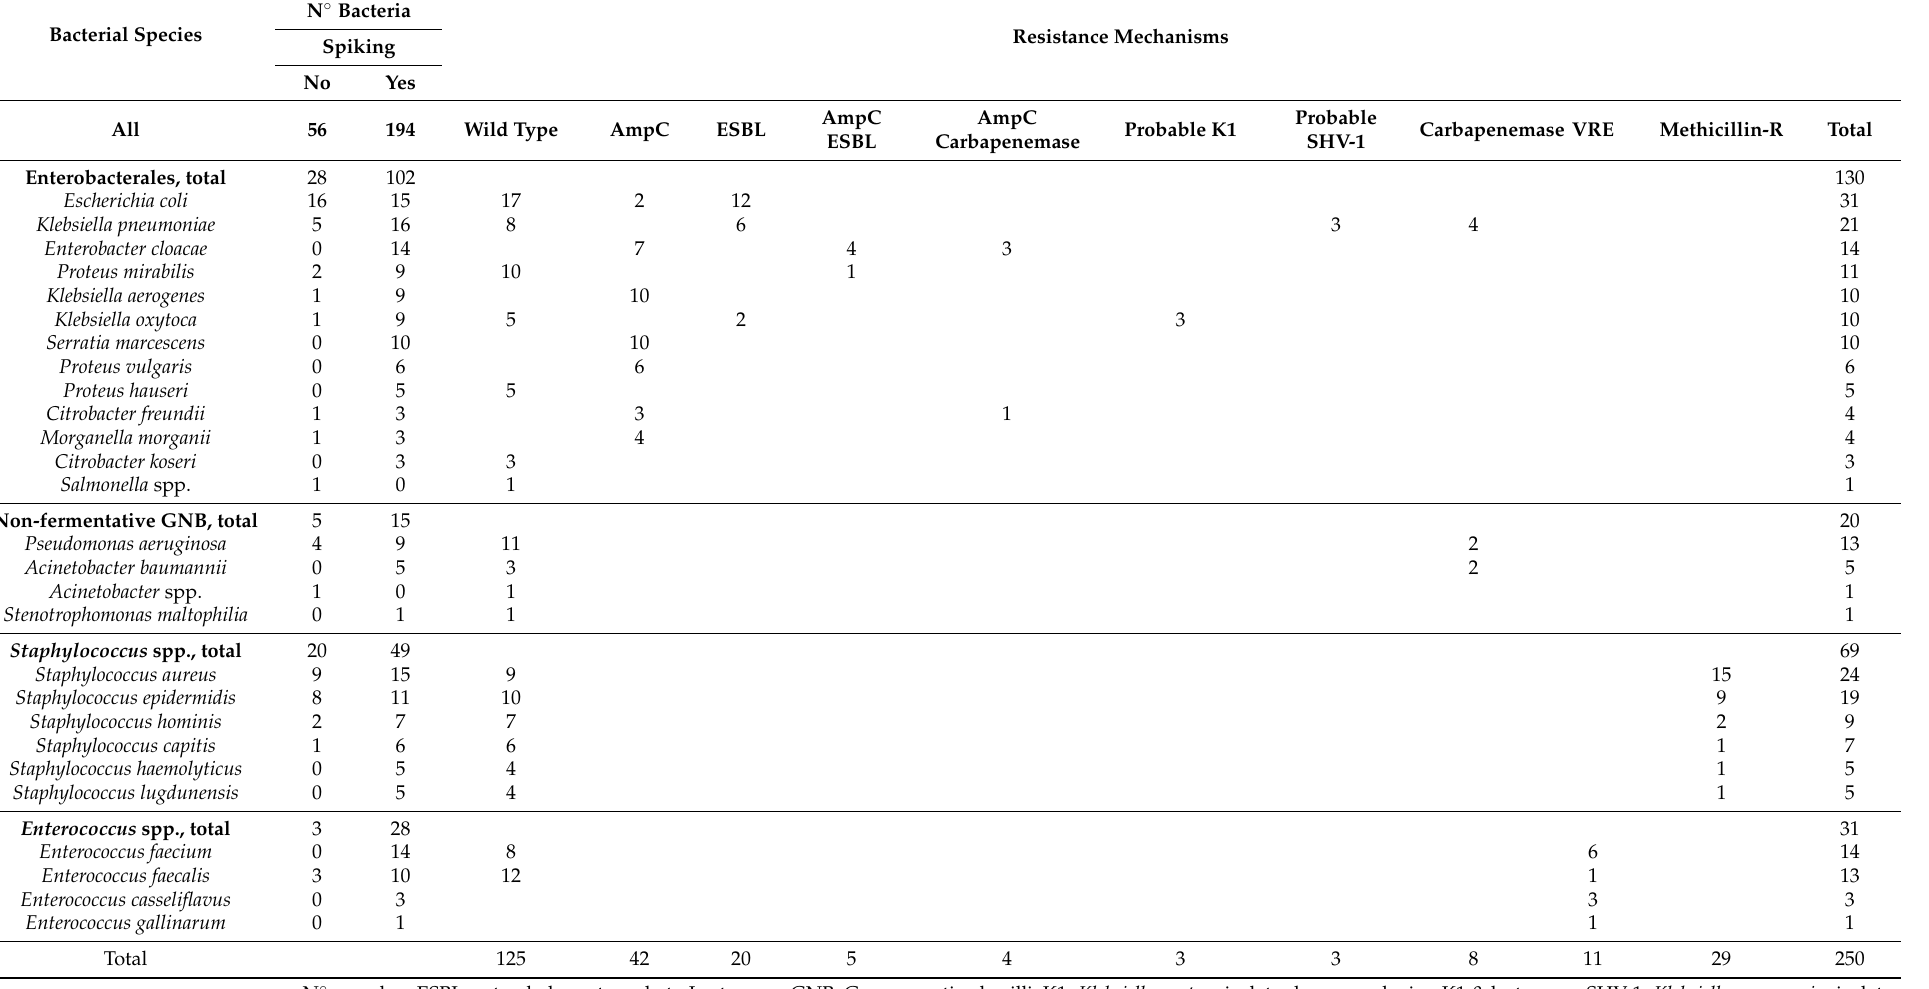
Table 1. Distribution of bacterial species tested in the study and their associated antibiotic resistance mechanisms ( n = 250). N ◦ Bacterial Species